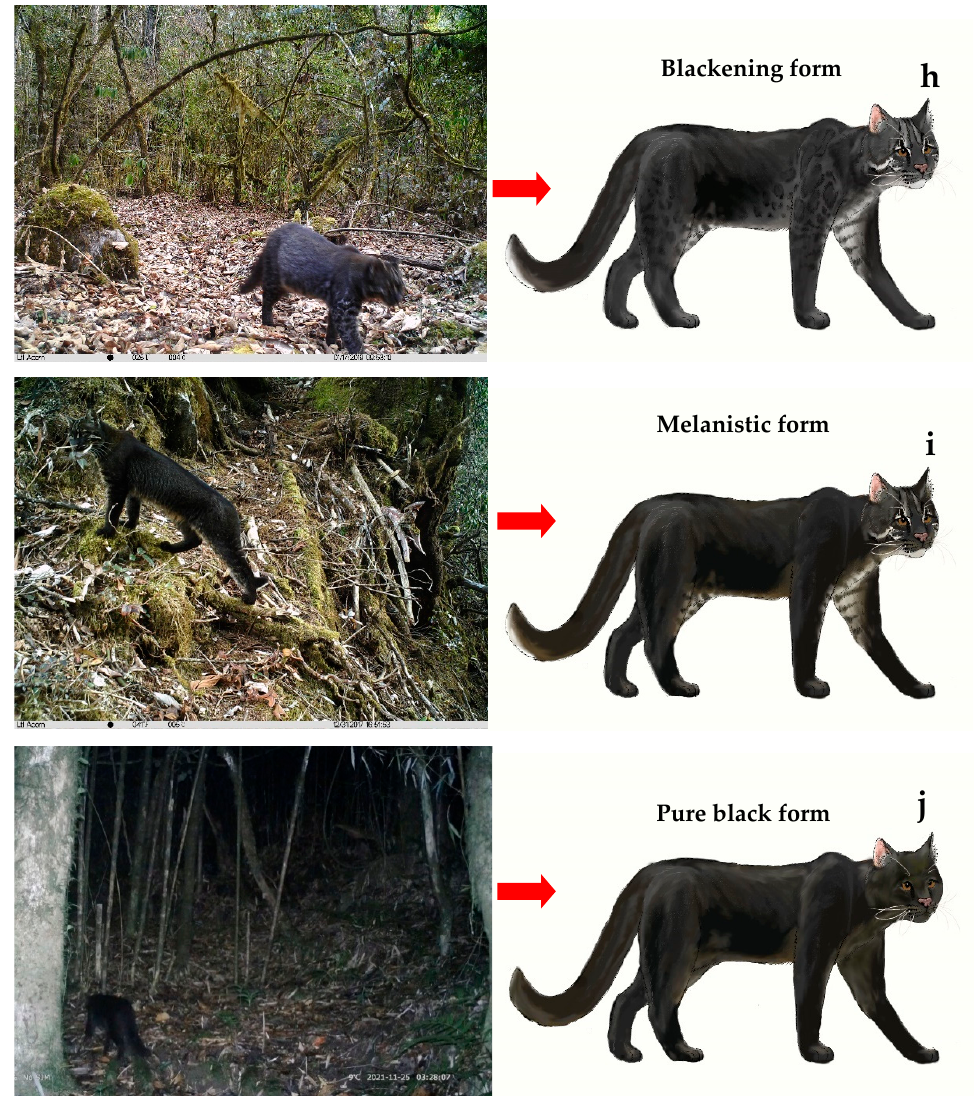
Figure 2. Vector images of ten coat morphs of the Asian golden cat in Yarlung Zangbo Grand Canyon National Nature Reserve, Tibet.